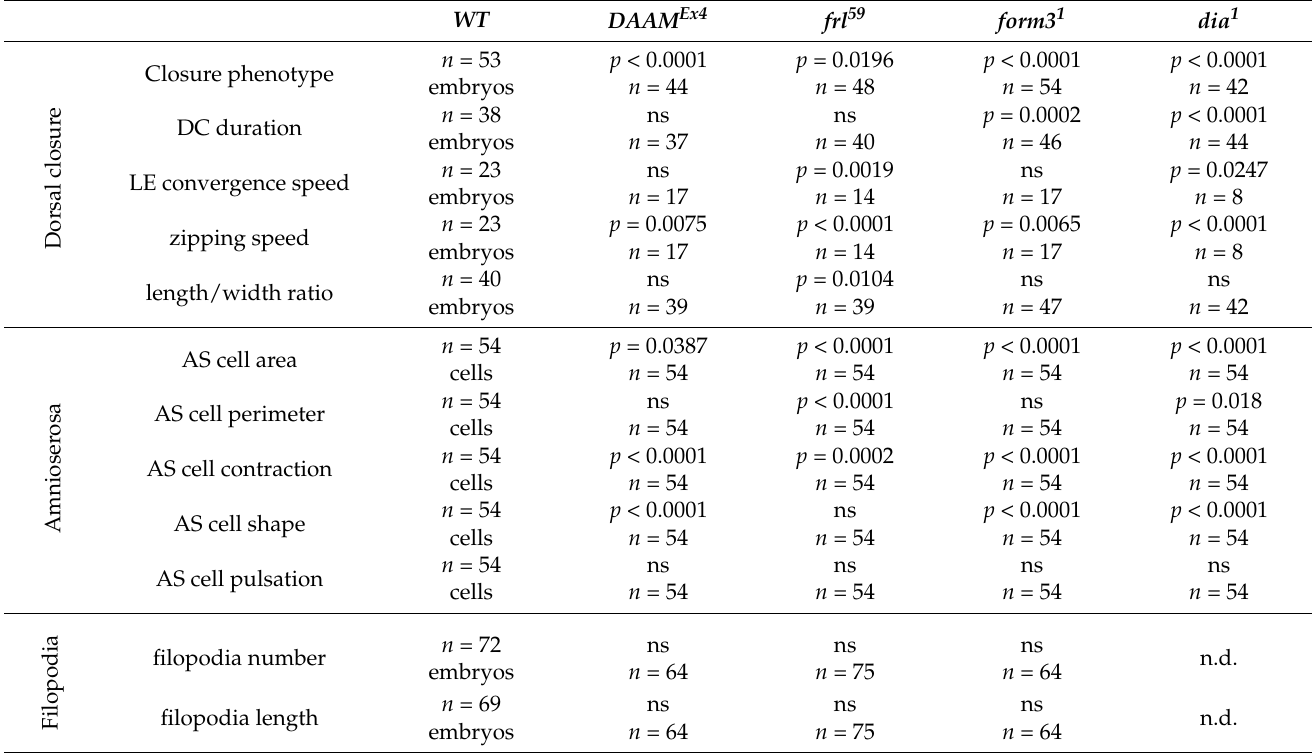
Table 1. Summary table of the sample numbers used and the significance levels obtained during analysis of the effects of the formin mutants on the different aspects of the dorsal closure process. All mutant embryos were compared to the WT control. n.d. = not done, ns= non-significant. WT DAAM Ex4 frl